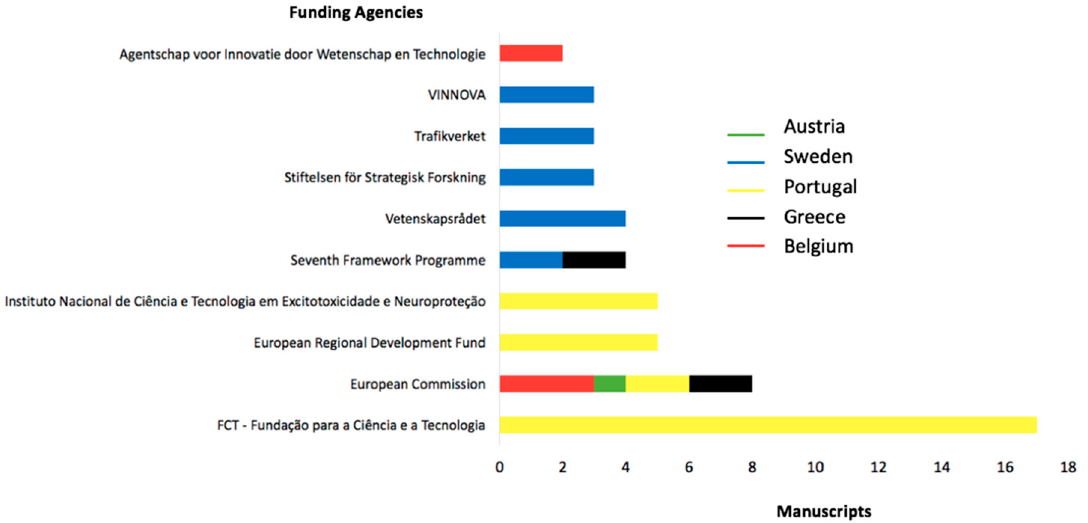
Figure 4. Documents by funding agencies (Top 10).